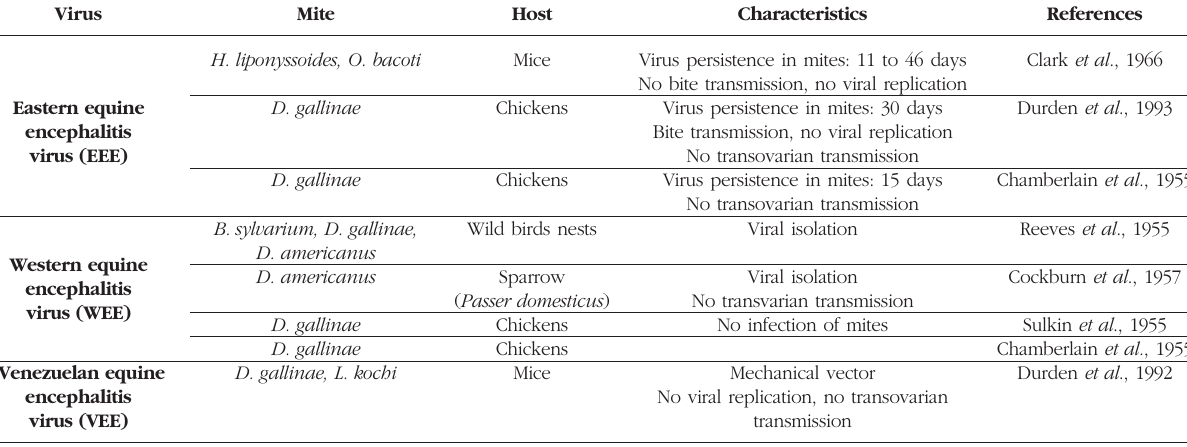
Table V. – Equine encephalitis virus transmitted by dermanyssoid mites. ( B. sylviarum = Bdellonyssus sylviarum , D. americanus = Der- manyssus americanus , H. liponyssoides = Haemogamasus liponyssoides , L. kochi = Laelaps kochi , O. bacoti = Ornithonyssus bacoti